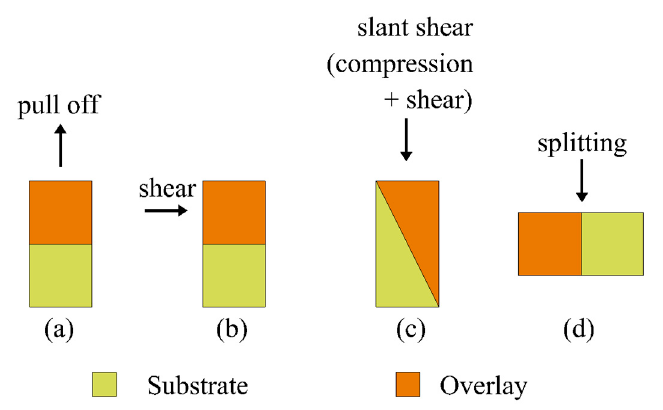
Figure 3. Tests to determine the bond between the concrete substrate and the overlay: ( a ) pull-o ff , ( b ) shear, ( c ) slant shear, ( d ) splitting